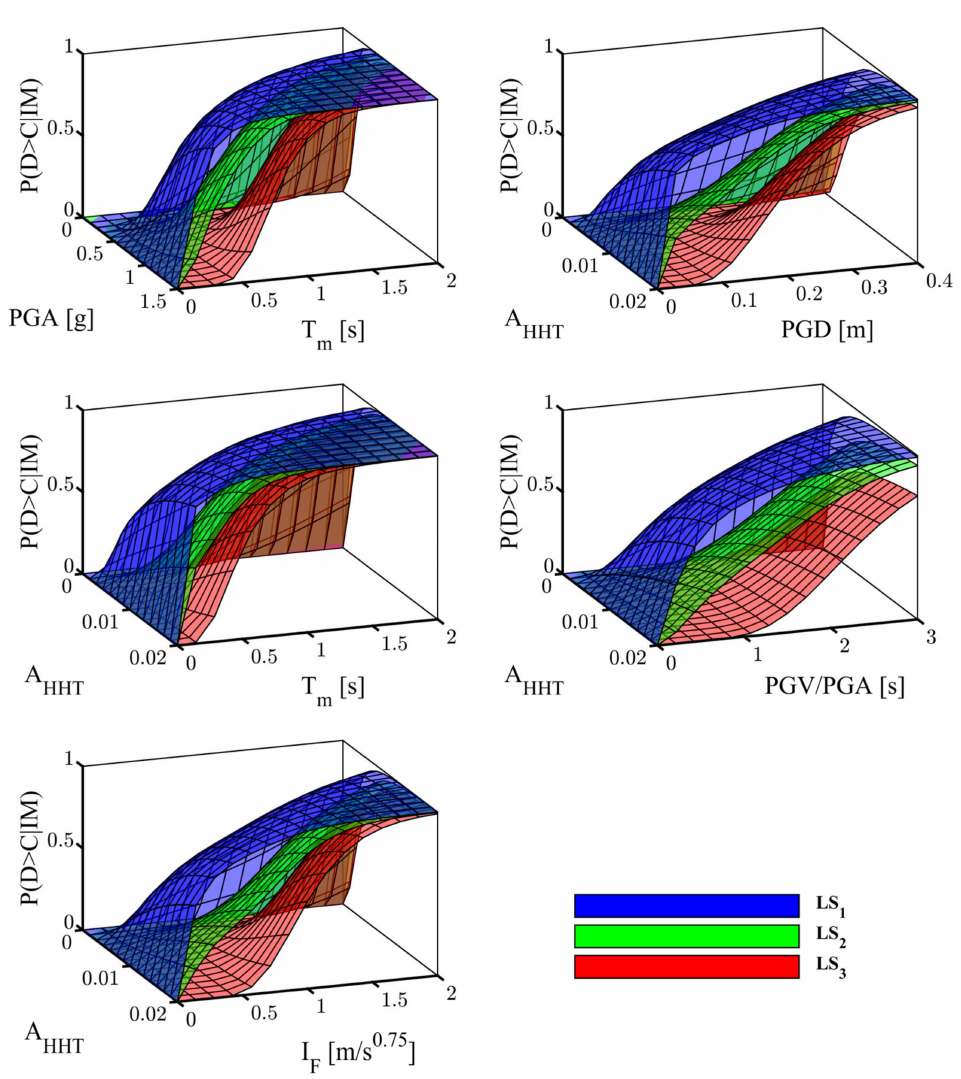
Figure 7. Fragility surfaces using vector-value